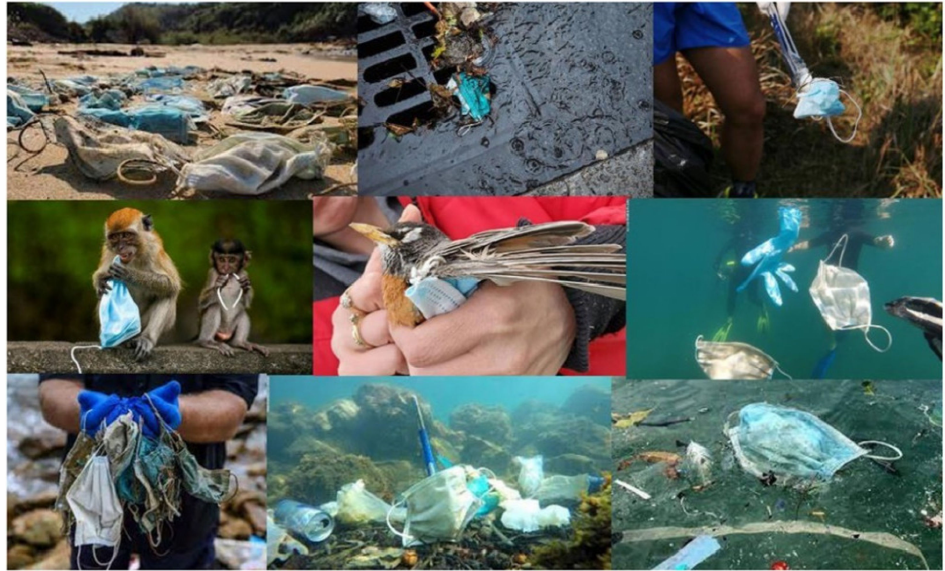
Figure 3. Pollution is caused by face masks